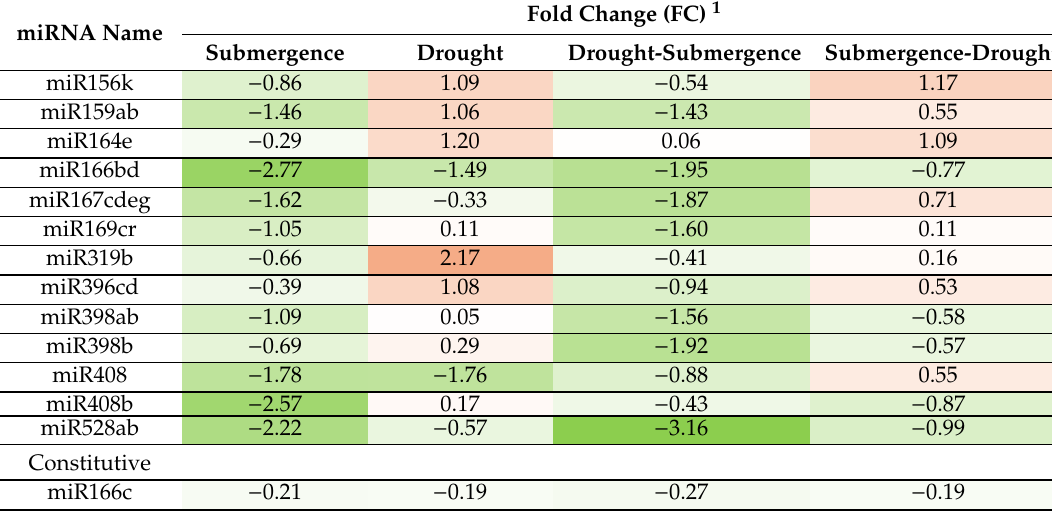
Table 3. Representative plant miRNAs responsive to single (submergence or drought) and alternated treatments (drought followed by submergence and submergence followed by drought) in teosinte plants. Fold Change (FC) 1 miRNA Name Submergence Drought Drought-Submergence